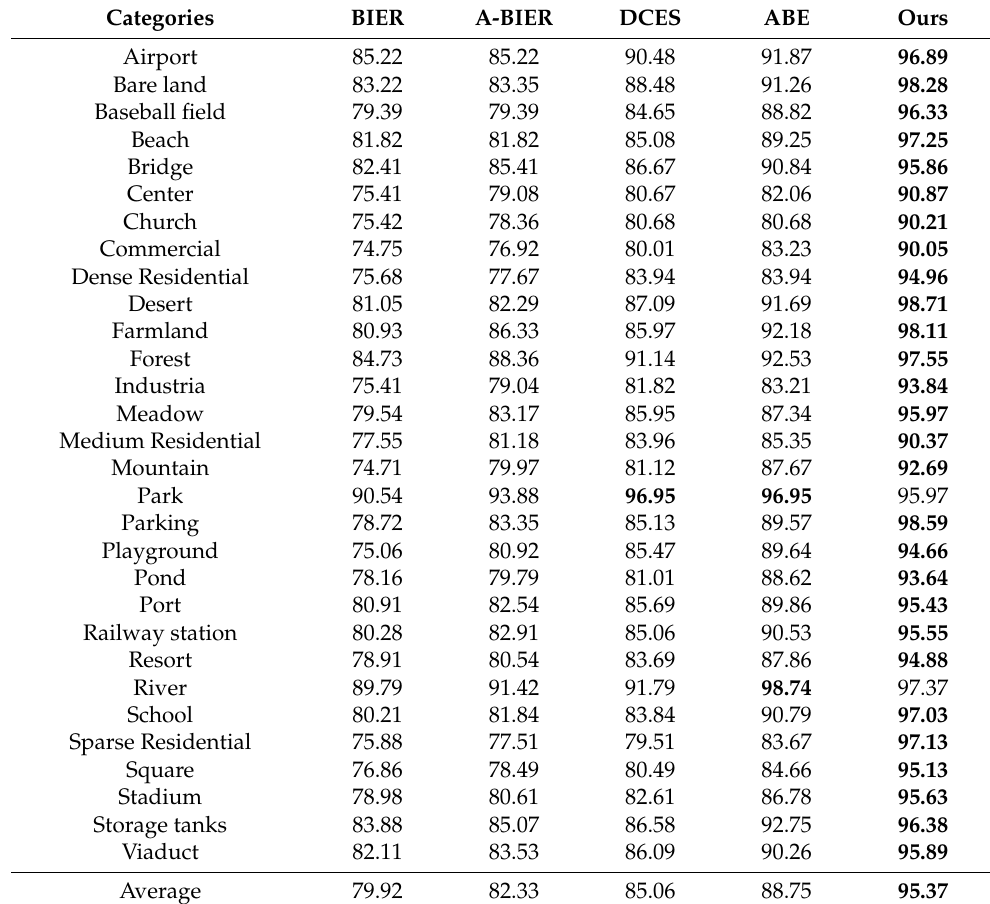
Table 7. mAP (%) of 30 geographic categories in AID with various RSIR